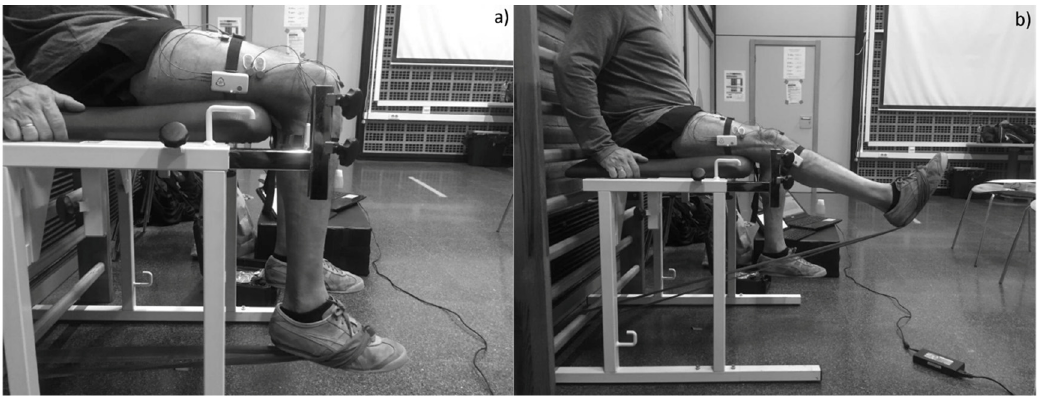
Figure 1. Knee extension exercise with elastic band. ( a ) initial phase of the exercise; ( b ) final phase of the